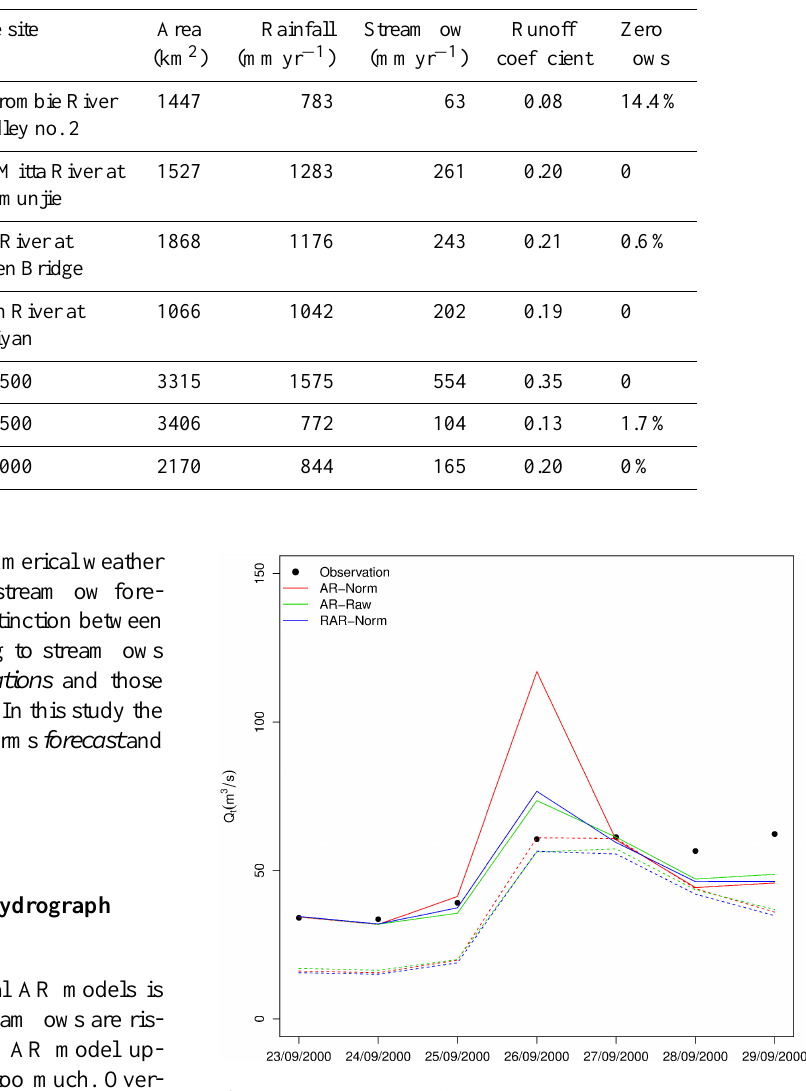
Figure 2. An example of over-correction caused by the AR-Norm model in the Mitta Mitta catchment. Dashed lines: forecasts from the base hydrological model (i.e. without error updating). Solid lines: forecasts with error